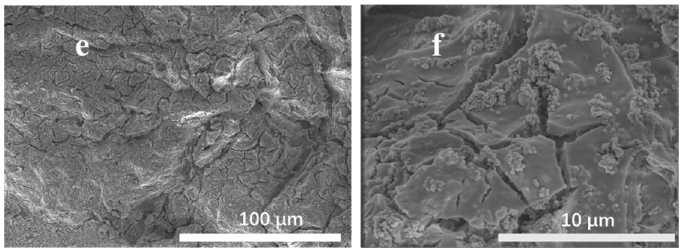
Figure 2. Scanning electron microscopy (SEM) images of sample 1 # ( a ) 100 um, ( b ) 20 um; sample 2 # ( c ) 100 um, ( d ) 10 um; and sample 3 # ( e ) 100 um, ( f ) 10 um.